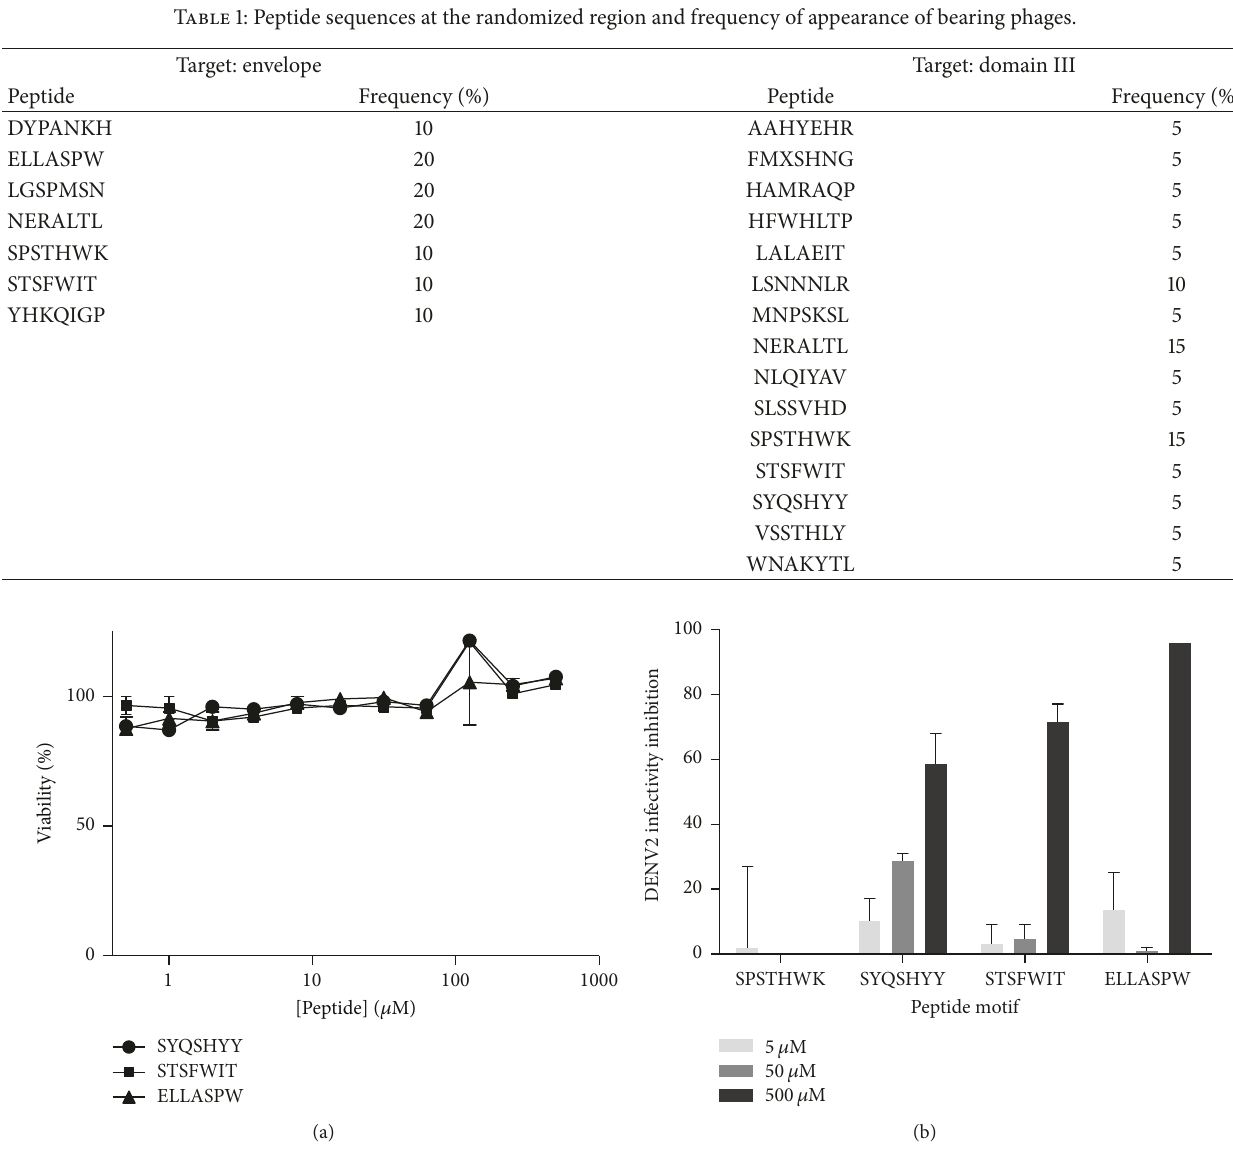
Figure 5: Biological activities of active peptides in Vero cells. (a) Cytotoxicity of active peptides. Cells were incubated with increasing concentrations of the peptide for 1h and washed away and cells incubated in maintenance medium for 24. Then cytotoxicity was estimated from ATP levels using luminescence. The viability was estimated by comparing with nontreated cells. Data is presented as means and standard deviations of two independent experiments. Medians were compared between the nontreated control and all other groups using Kruskal- WalliswithDunn’smultiplecomparisontest.(b)DENV2infectivityinhibitionbypeptides,asshowninaplaquereductionassay.Thereduction in the number of plaques was estimated by comparison with virus-infected cells alone. The peptide SPSTHWK is presented as negative control since it showed no consistent inhibitory activity against the virus. Data is presented as means and standard deviations of two independent